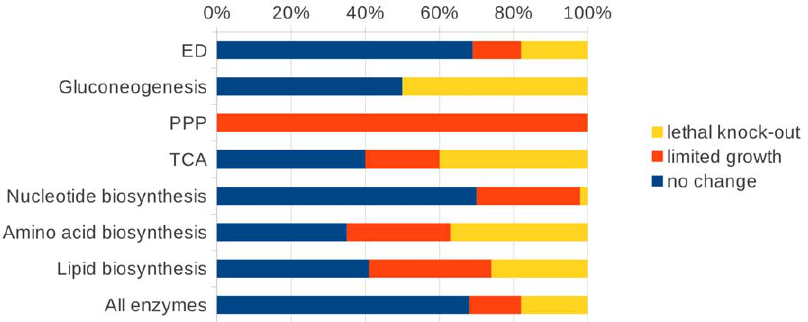
Figure 8. Diagrams of the influence of single-gene deletions in iTU515 on the central carbon metabolism and the whole model (all enzymes) in iTU515.